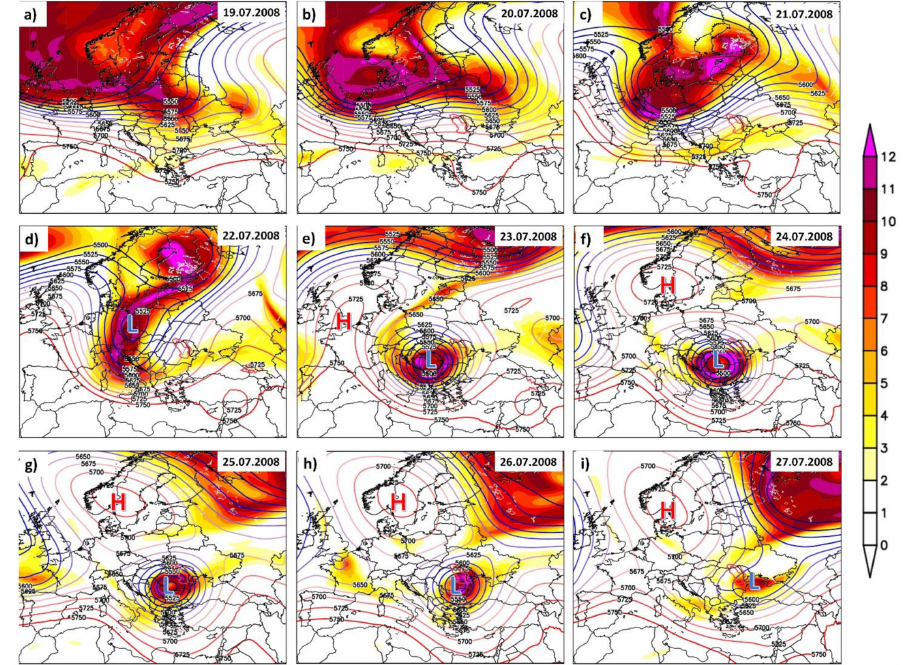
Figure 5. Daily potential vorticity (PV) at 330 K (shaded colors) and daily geopotential height at 500 hPa (Z500) (contour lines) for: ( a ) 19 July 2008; ( b ) 20 July 2008; ( c ) 21 July 2008; ( d ) 22 July 2008; ( e ) 23 July 2008; ( f ) 24 July 2008; ( g ) 25 July 2008; ( h ) 26 July 2008, and ( i ) 27 July 2008. Units: PV (PVU) and Z500 (m). L (blue) denotes low pressure system and H (red) denotes high pressure